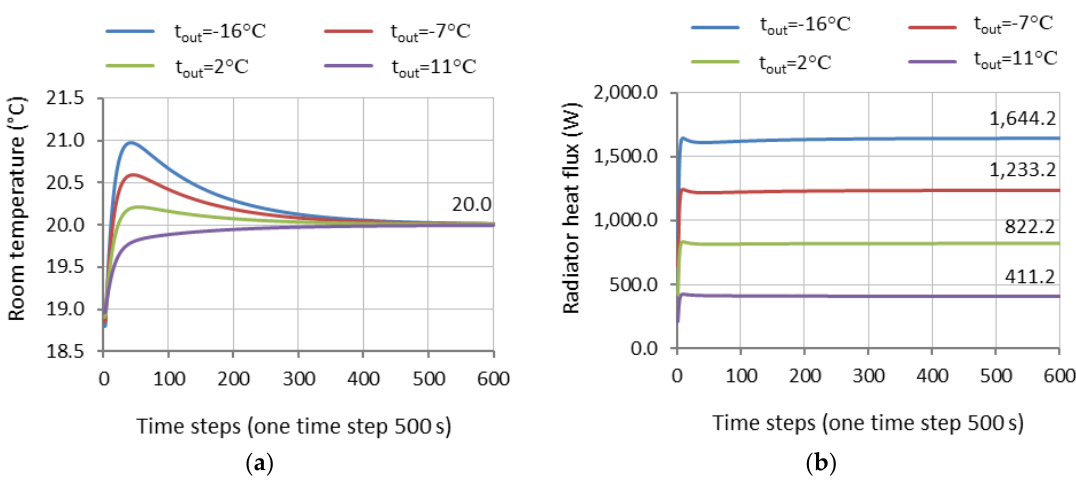
Figure 6. ( a ) Room temperature values in time; ( b ) Radiator heat flux 𝑄 𝑟𝑎𝑑 , for four different values of outside temperature.